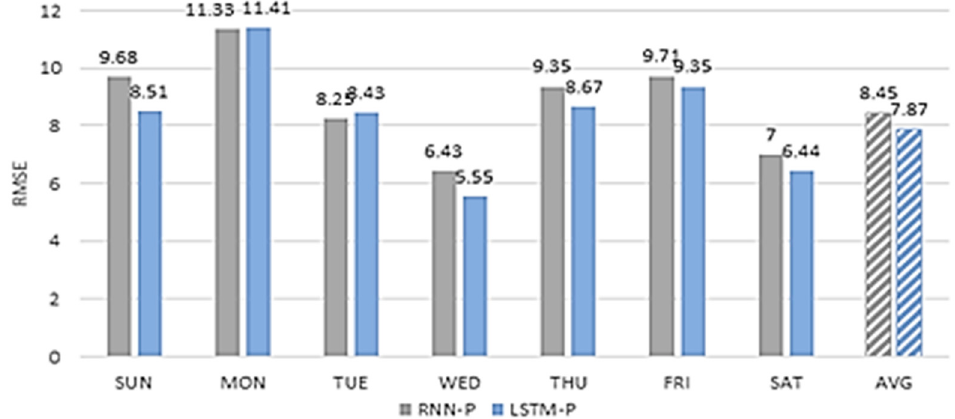
Figure 22. RMSE value of the speed predicted using the RNN and the LSTM.